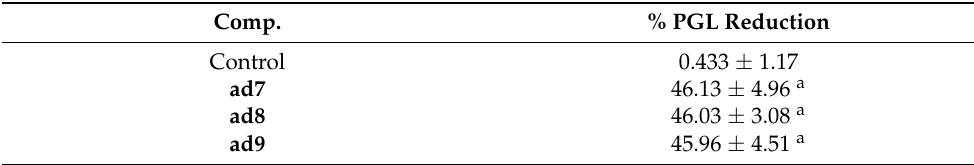
Table 32. Hypoglycemic activity of the compounds ( ad7 – ad9 ) using a streptozotocin-induced diabetic rat model. Comp.